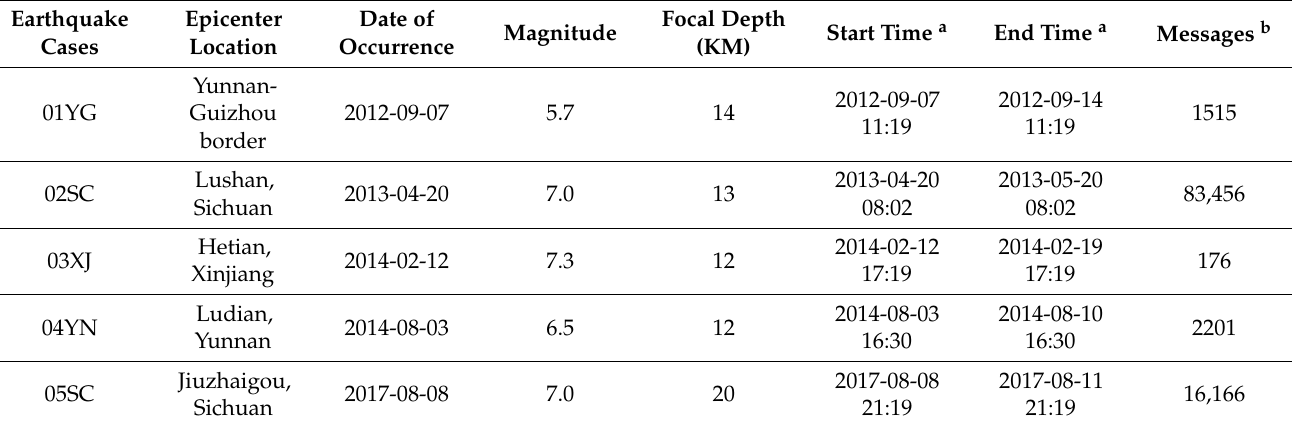
Table 1. Earthquake cases and microblog information